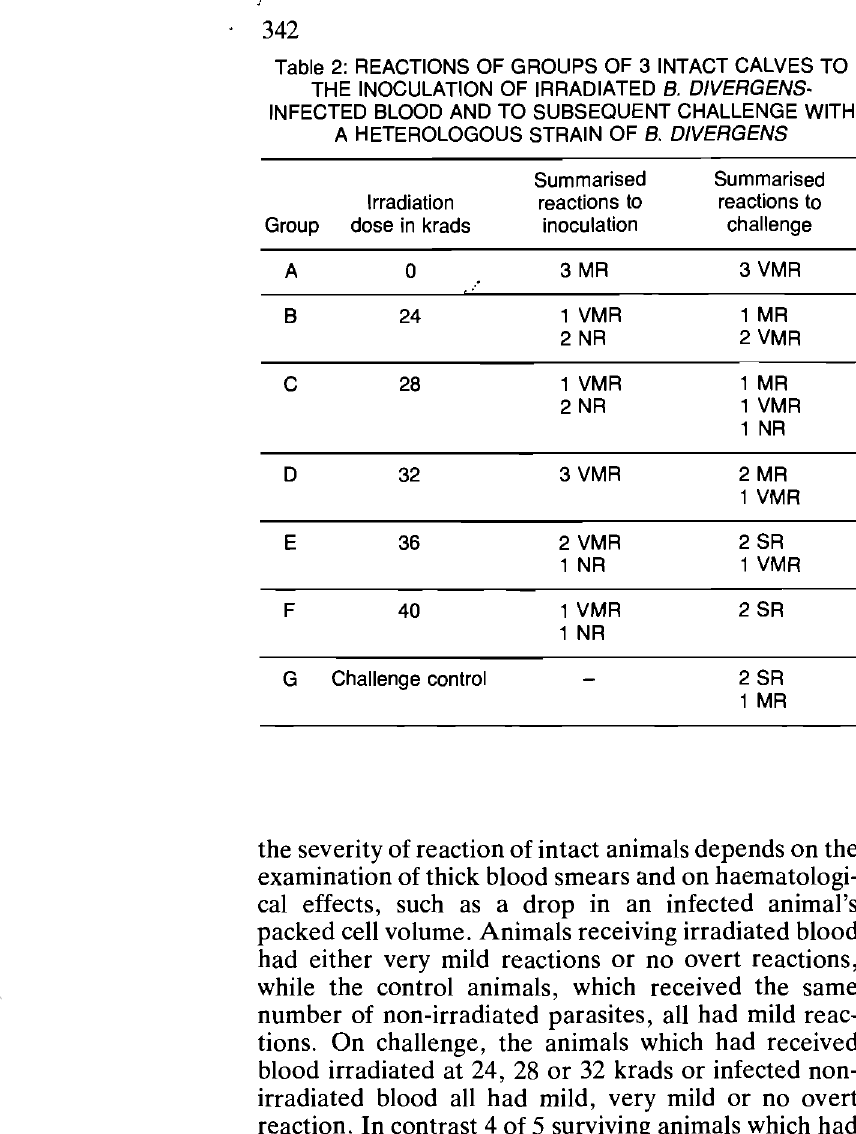
Table 3: AGHADAVEY FIELD TRIAL OF IRRADIATED BABESIA DIVERGENS BLOOD VACCINE: SUMMARISED REACTIONS OF GROUPS OF VACCINATED CALVES TO FIELD CHALLENGE WITH B. DIVERGENS